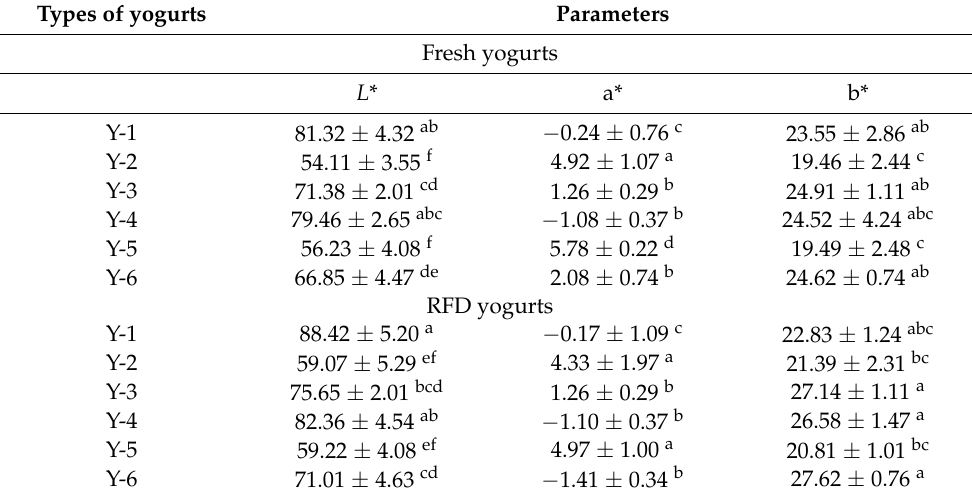
Table 3. Color characteristics ( L *—lightness, a*—red/green, b*—blue/yellow) of fresh and RFD